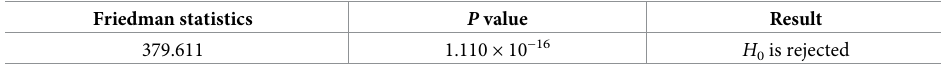
Table 5. The Friedman test with significance level of